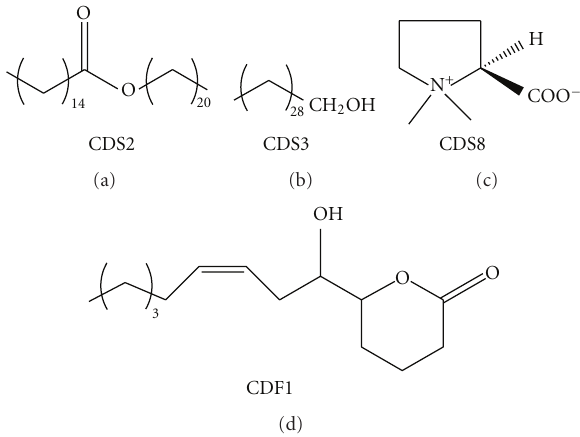
Figure 1: Pure compounds obtained from C. decidua after solvent fractions being eluted and purified by column chromatography. Compounds CDS3 (25mg) and CDS8 (50mg) were identified as triacontanol and 2-carboxy-1,1-dimethylpyrrolidine. While com- pound CDS2 is characterized as heneicosylhexadecanoate. The column was prepared in petroleum ether using silica gel (60–80) as an adsorbent and eluted with petroleum ether/chloroform, chloro- form, chloroform/methanol mixtures of increasing polarity. CDF1 was isolated (15mg) from flowers from the chloroform fraction of the extract. It was identified as 6-(1-hydroxy-non-3-enyl) tetrahydropyran-2-one and is